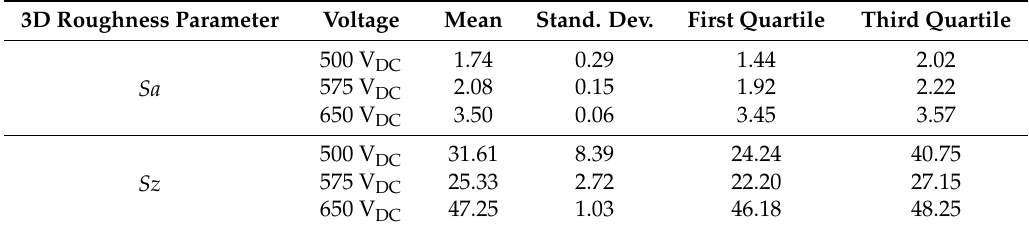
Table 2. Statistical descriptions of 3D roughness parameters ( Sa and Sz ) in micrometers.